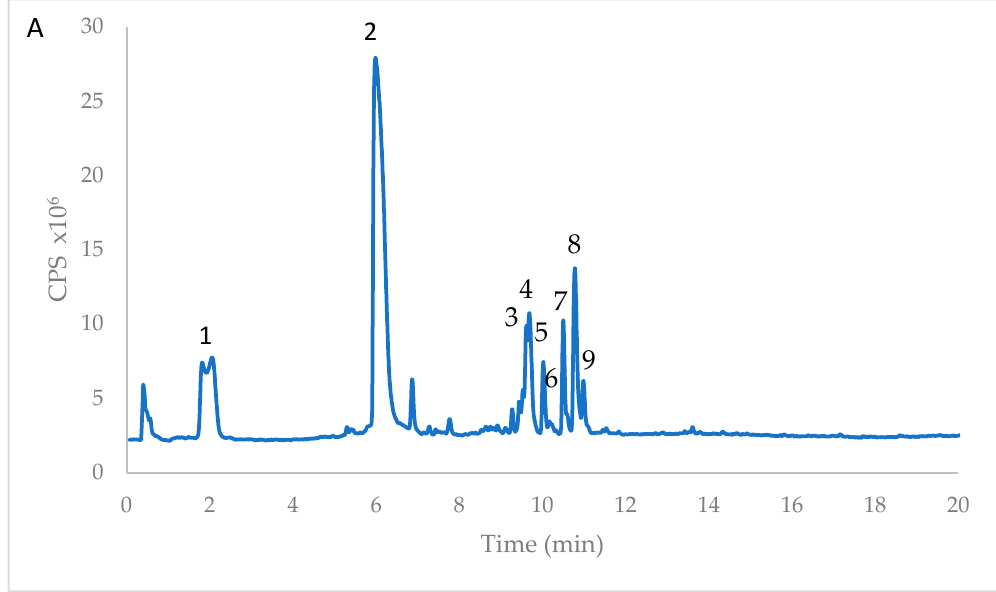
Figure 1. High performance liquid chromatography time-of-flight mass spectrometry (HPLC / MS-TOF) chromatogram of Opuntia ficus-indica extract from immature cladodes ( imm ). The chromatographic profile of mature cladode ( m ) extract was similar, except for isorhamnetin glucoside (peak 9), only present in imm . The numbers indicating peaks refer to the identified compounds reported in Table1. Table 1. Identification of phenolic acids and flavonols in Opuntia ficus-indica extracts (from imm and m ) by means of High performance liquid chromatography time-of-flight mass spectrometry HPLC/TOF (M − H) − .